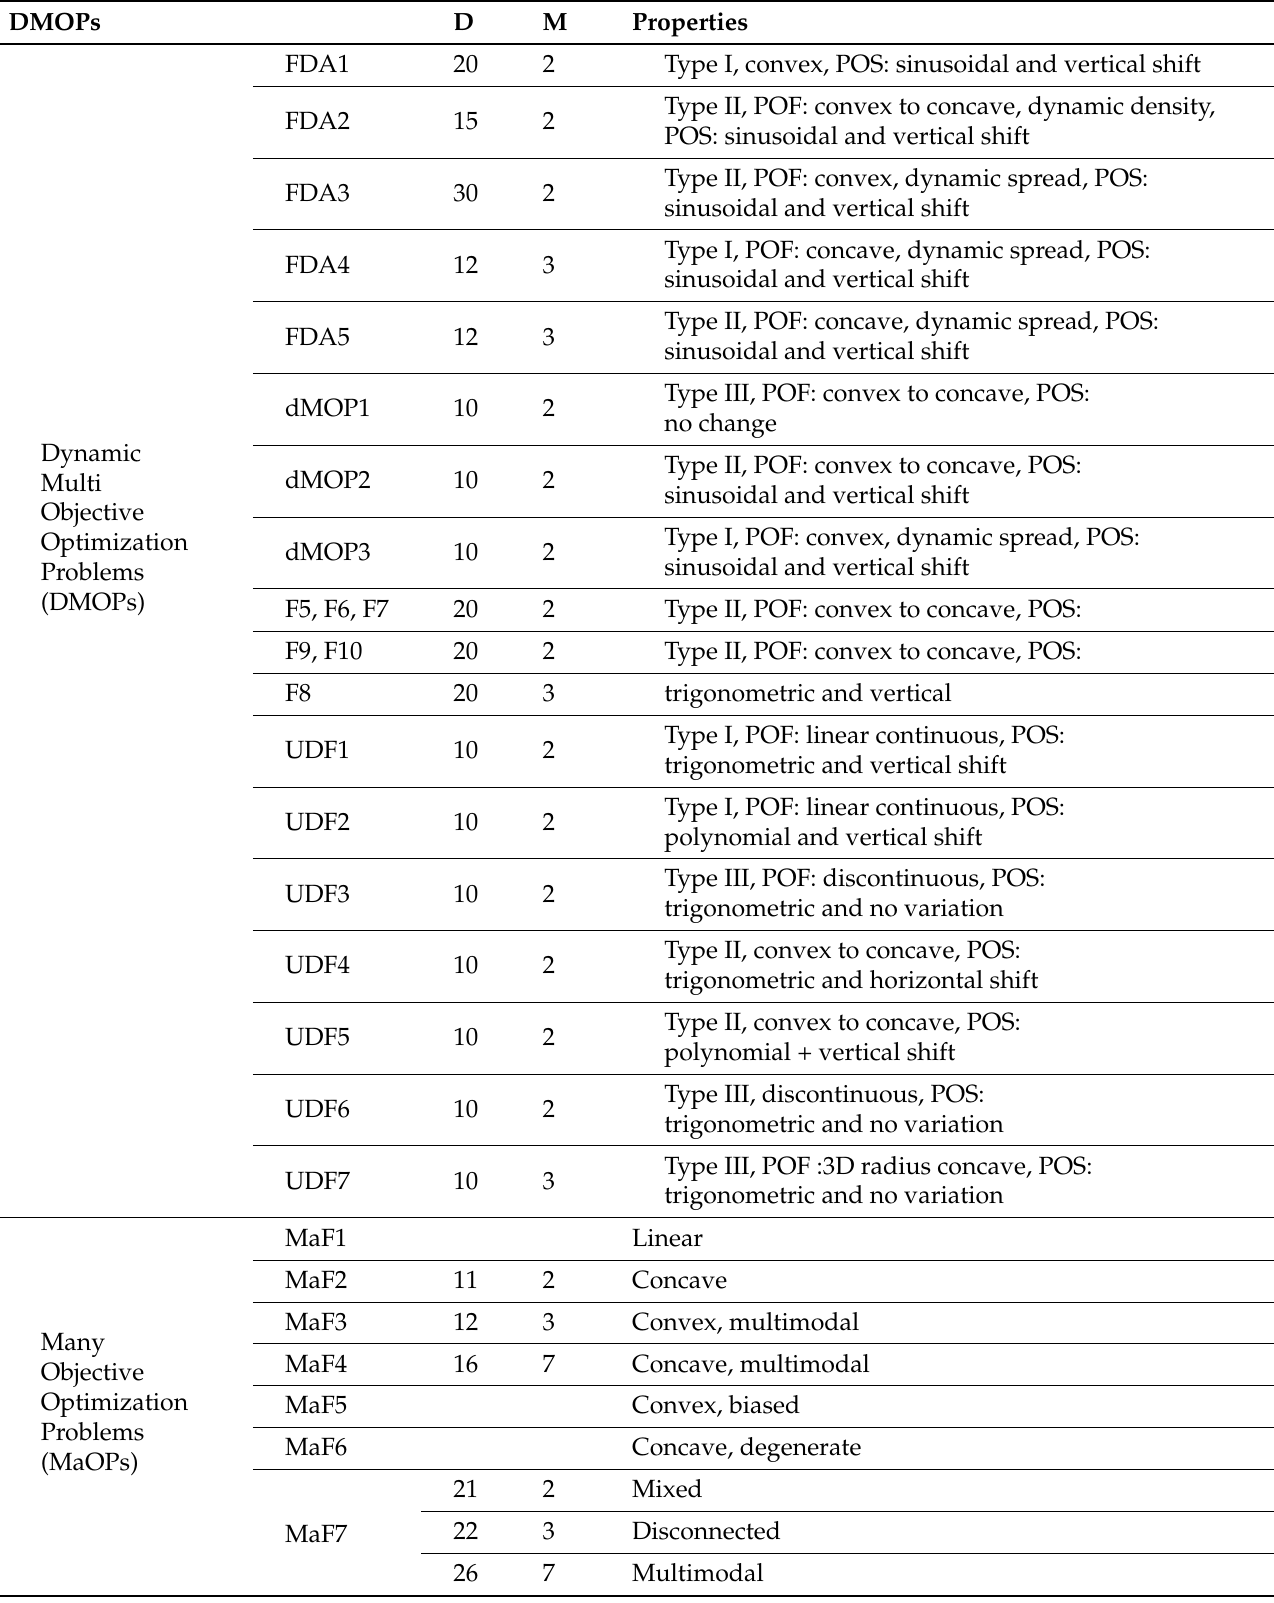
Table 5. Properties of the tested benchmarks: DMOPs and